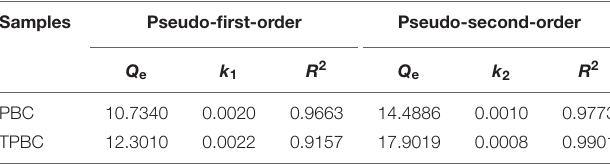
TABLE 2 | Kinetic parameters of pseudo-first-order and pseudo-second-order for the TC adsorption.